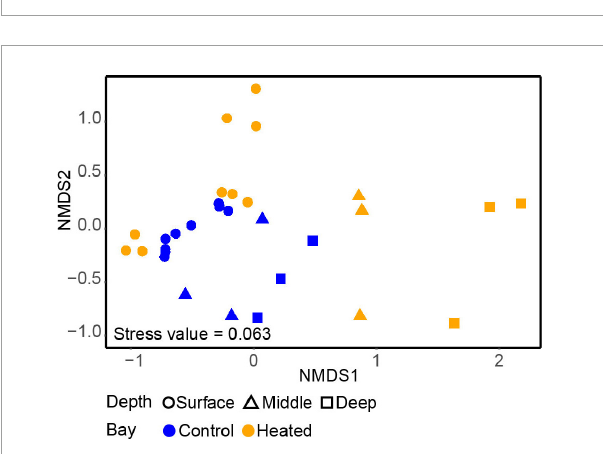
FIGURE1 Sulfate concentrations; mean ( n = 3) ± s.d. sulfate concentration in the heated and control bays at the three different depths. Sulfate fluxes for each bay were calculated based on average temperature measured in each bay and assumed salinity of 6 psu and sediment porosity of 0.8 (within the range of uncompacted mud).